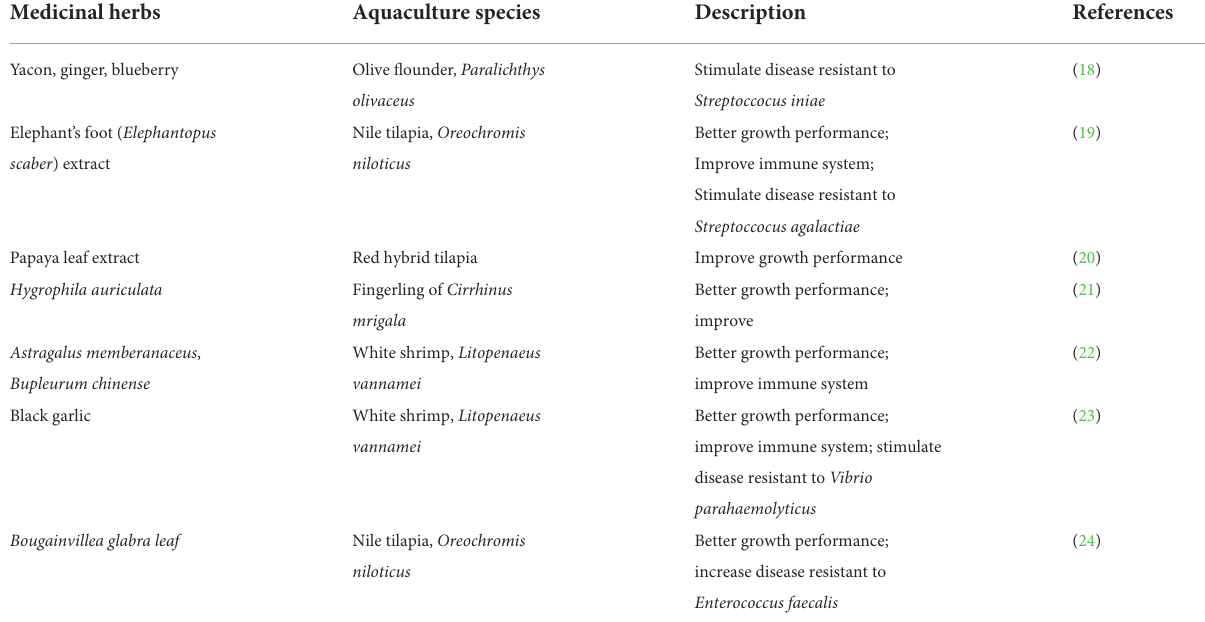
TABLE 1 Recent studies of medicinal herb application in